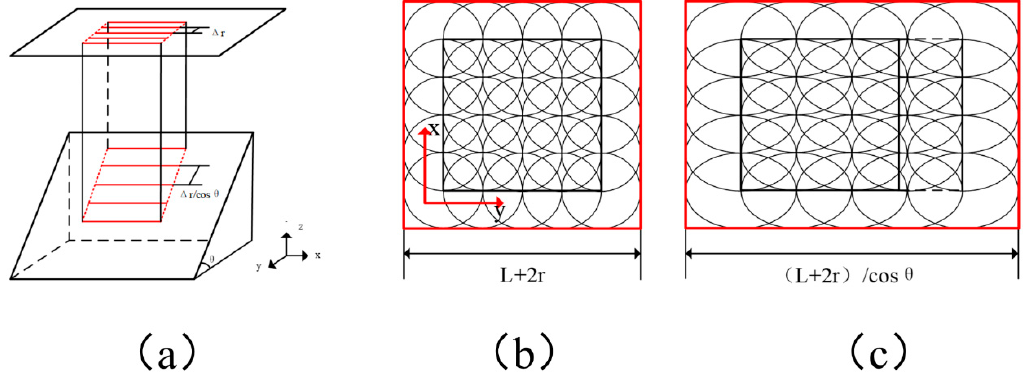
Figure 6. A schematic of the projected etching area changing with the incident angle ( a ), the ideal etching area ( b ) and the real elongated etching area ( c ). Due to distortion in the y direction, the etching accuracy was reduced.